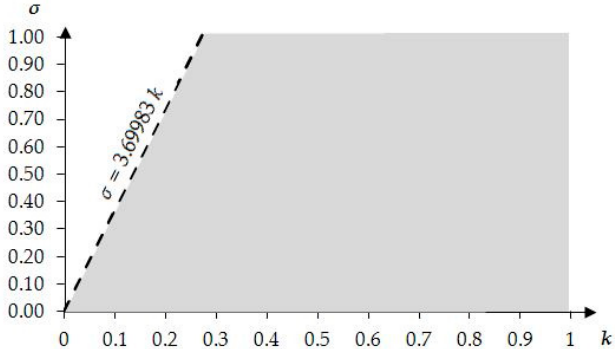
Figure 5. Range of possible values of the parameters k and σ .